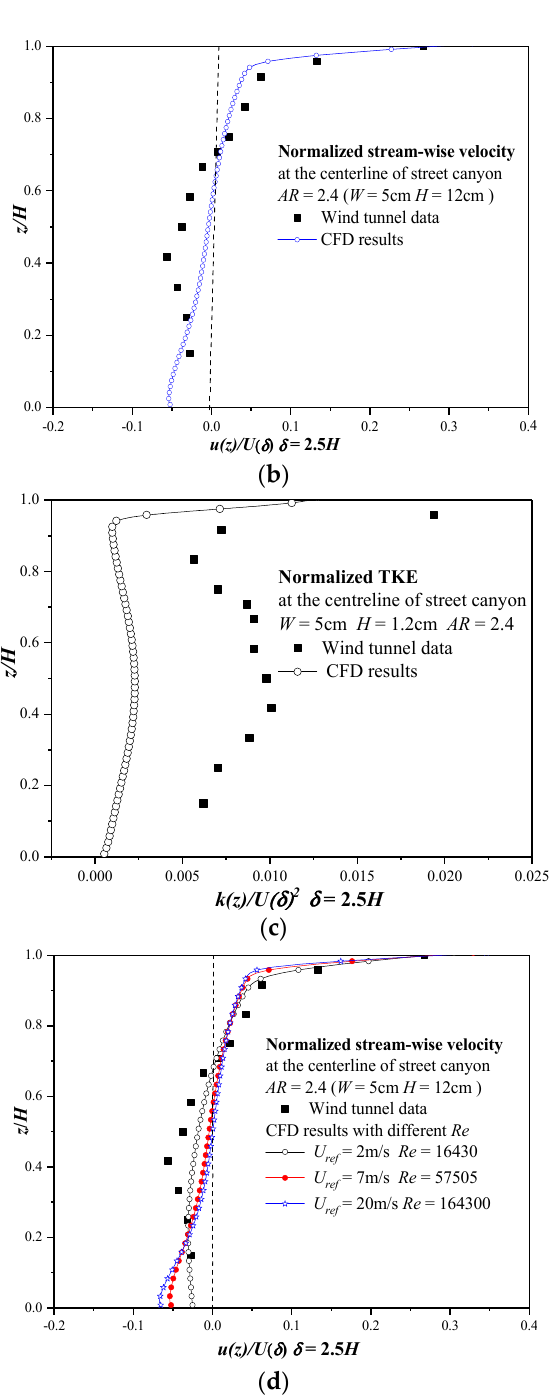
Figure A1. CFD validations by wind-tunnel data ( H ~0.1 m), with RNG k- ε model and scalable wall function. ( a ) Vertical profile of normalized velocity ratio with three grids, AR = 4. ( b ) Vertical profile of normalized stream-wise velocity ratio with moderate grid, AR = 2.4. ( c ) Vertical profile of normalized TKE with moderate grid, AR = 2.4. ( d ) Vertical profile of normalized velocity ratio with moderate grid and different Reynolds number, AR = 2.4.